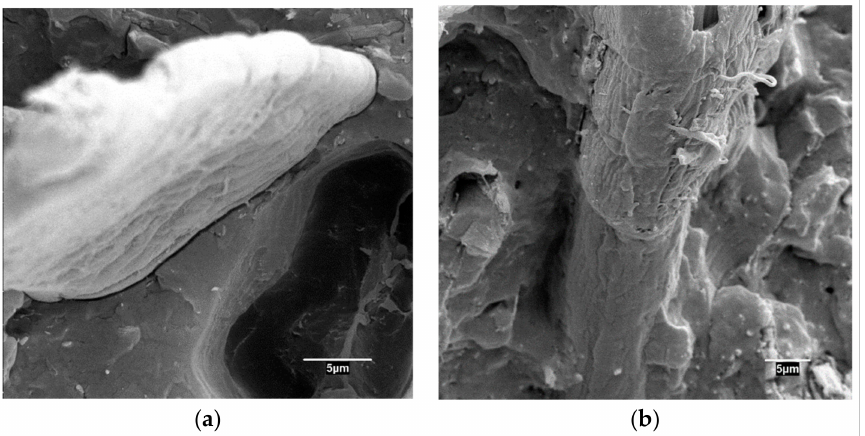
Figure 2. Micrographs of old newspaper fibers (ONPF) reinforced polypropylene (PP) composites, uncoupled ( a ) and coupled with a 6% w / w polypropylene functionalized with maleic anhydride (MAPP) ( b ).